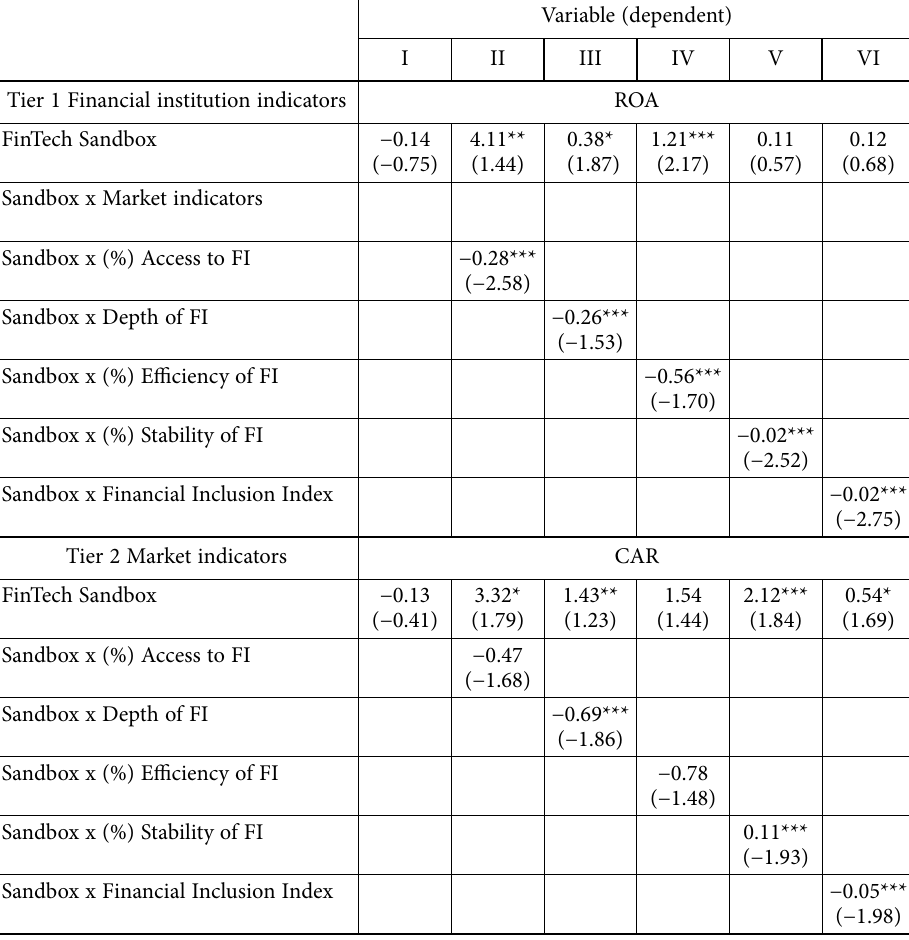
Table 5. Z-score indicators by developing FinTech